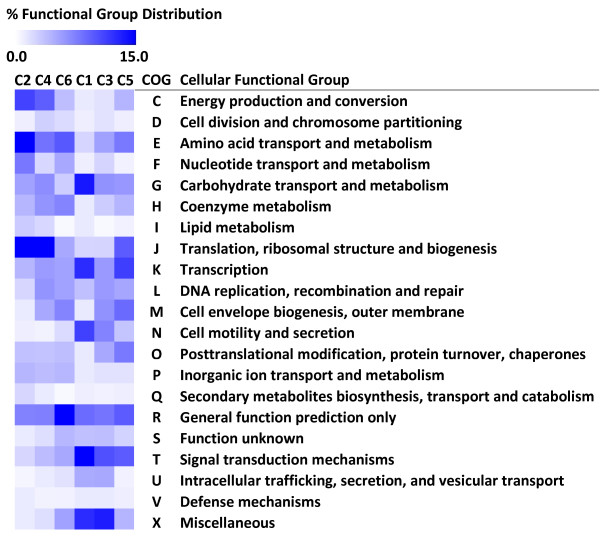
Functional distribution of differentially expressed genes within clusters. Calorimetric representation of the percentage distribution of genes, within each of the clusters identified (see Figure 2), across the different Clusters-of-Orthologous-Groups (COG) cellular functional categories. Clusters (C2, C4, C6) and (C1, C3, C5) are clusters in which the genes displayed a decreasing or increasing trend in expression, respectively, in various growth phases during Avicel® fermentation by Clostridium thermocellum ATCC 27405.